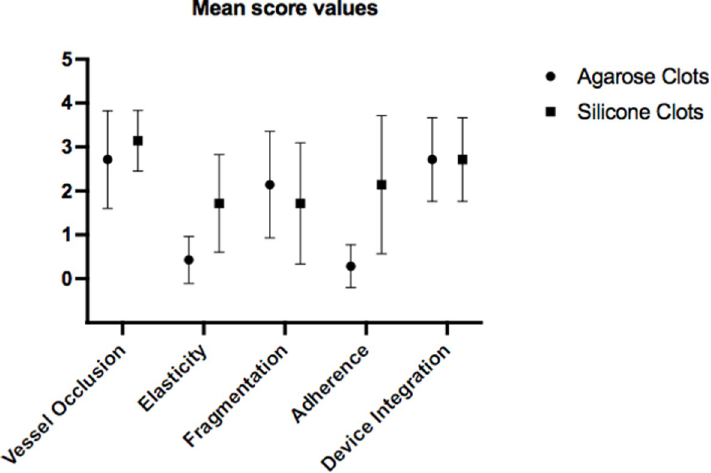
Fig 2. Error bar graph comparing mean score values for agarose- and silicone-based artificial clots. Note specially the different mechanical behaviors concerning clot elasticity and adherence. Both clot groups presented a good to very good vessel occlusion and device